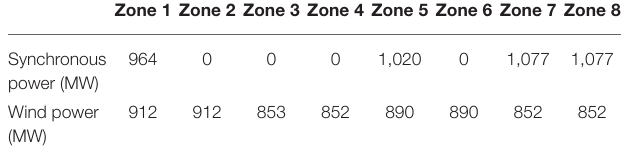
TABLE 4 | Synchronous power and wind power.